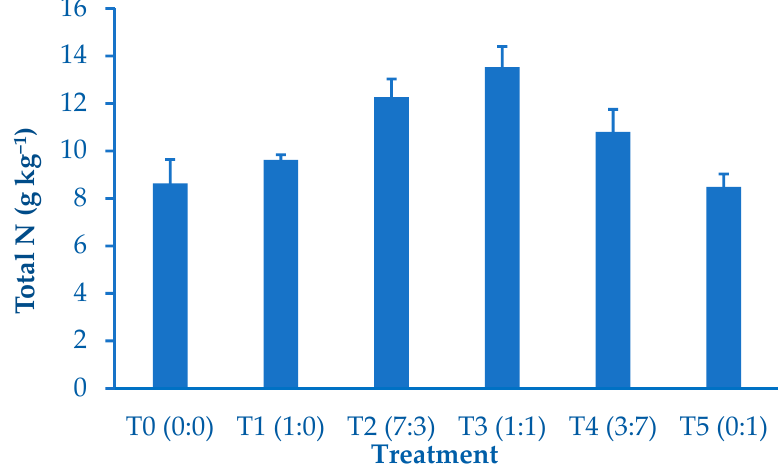
Figure 1. Total nitrogen content in leaves of Camellia oleifera ‘Xianglin 27’ seedlings fertigated with six nutrient solutions varying in NO 3 − to NH 4+ ratios.